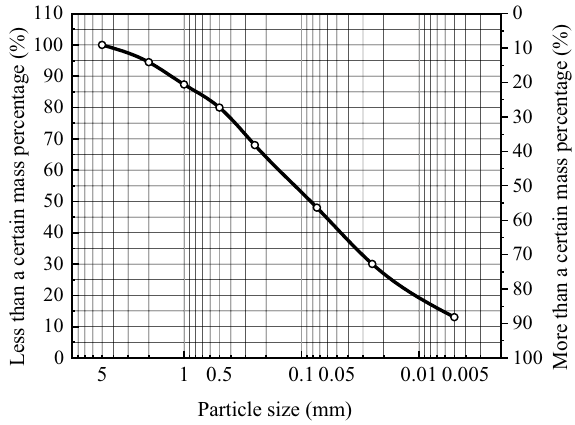
Figure 22. Particle gradation curves for eathen soils.